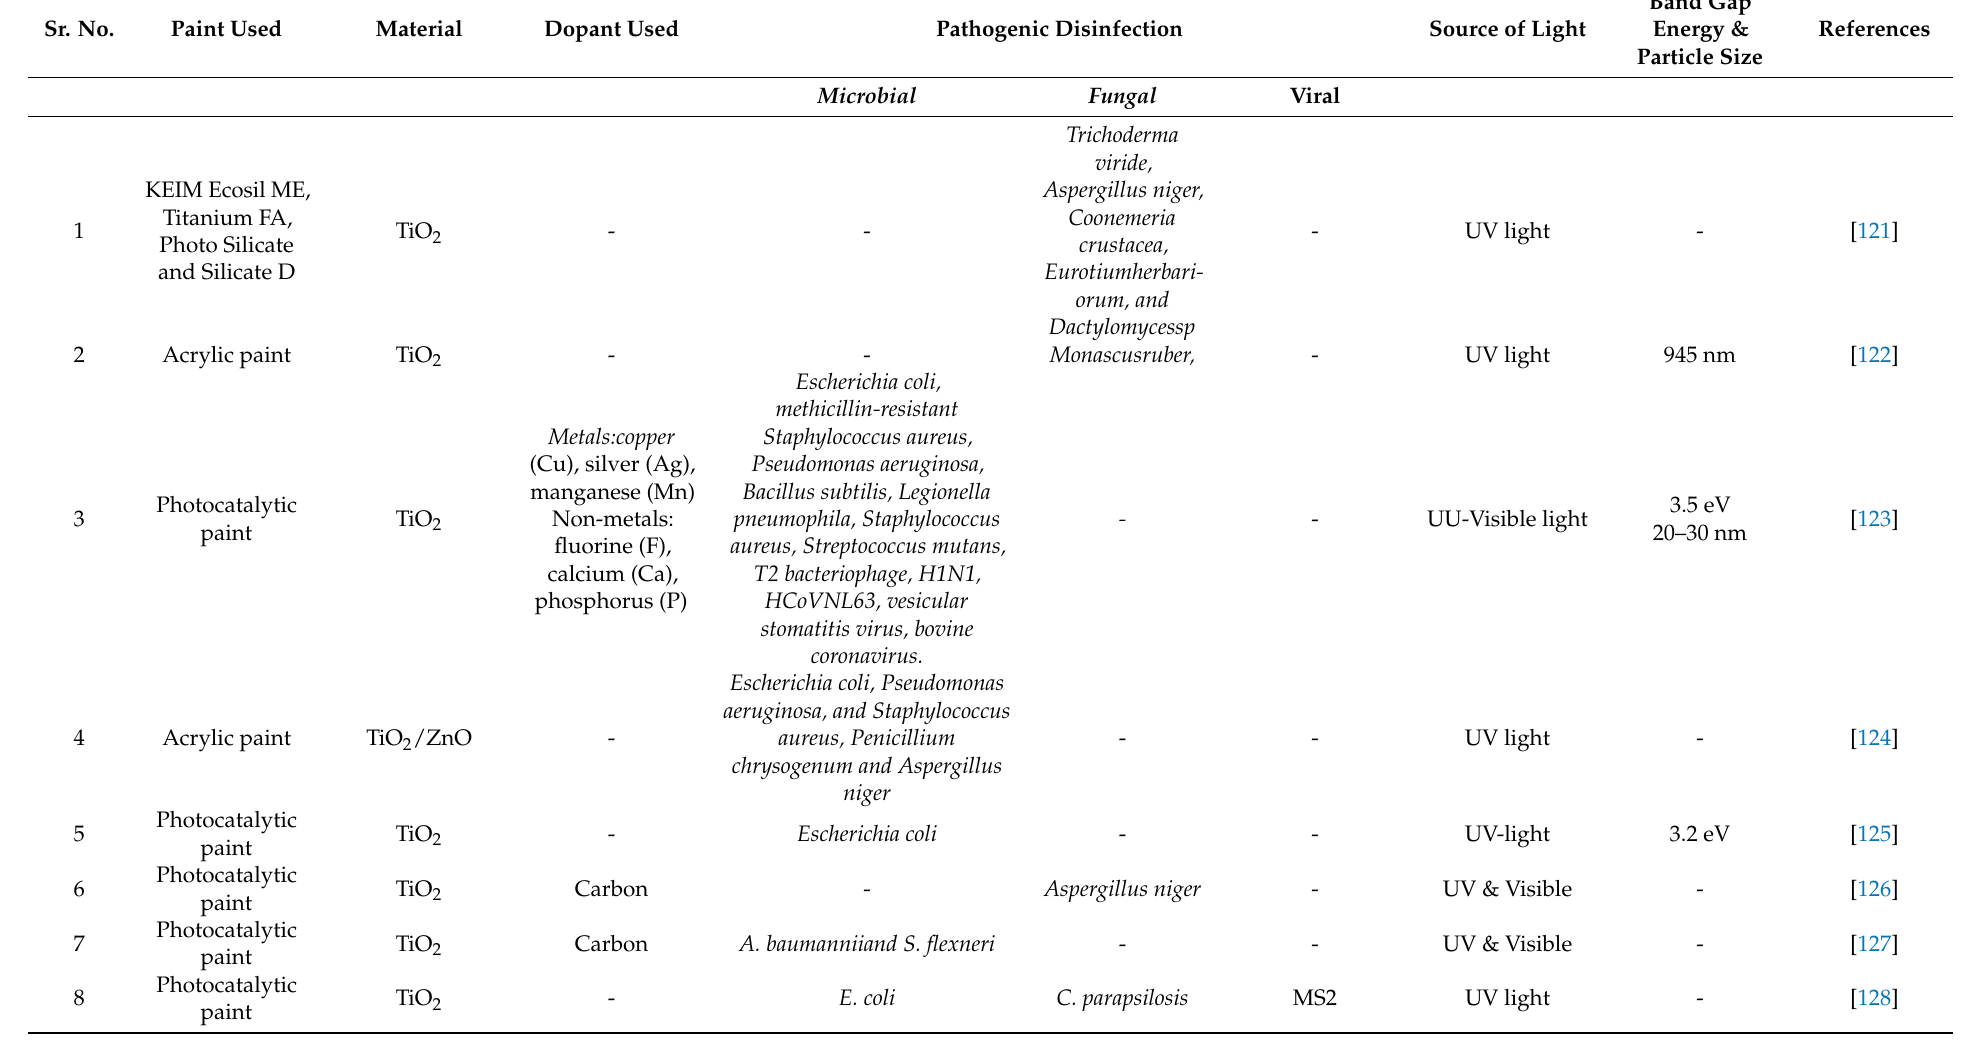
Table 4. The Summary of Photocatalytic Paints used in pathogenic disinfections.